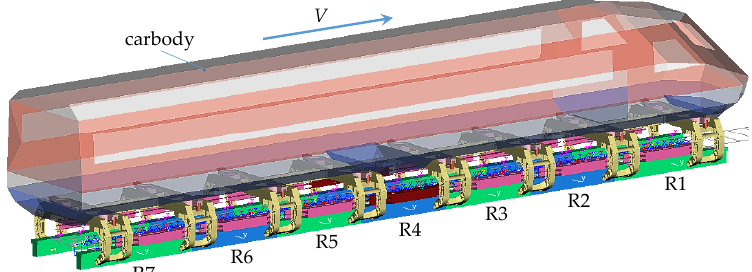
Figure 3. Rigid-flexible coupled dynamic model of high-speed maglev vehicle.